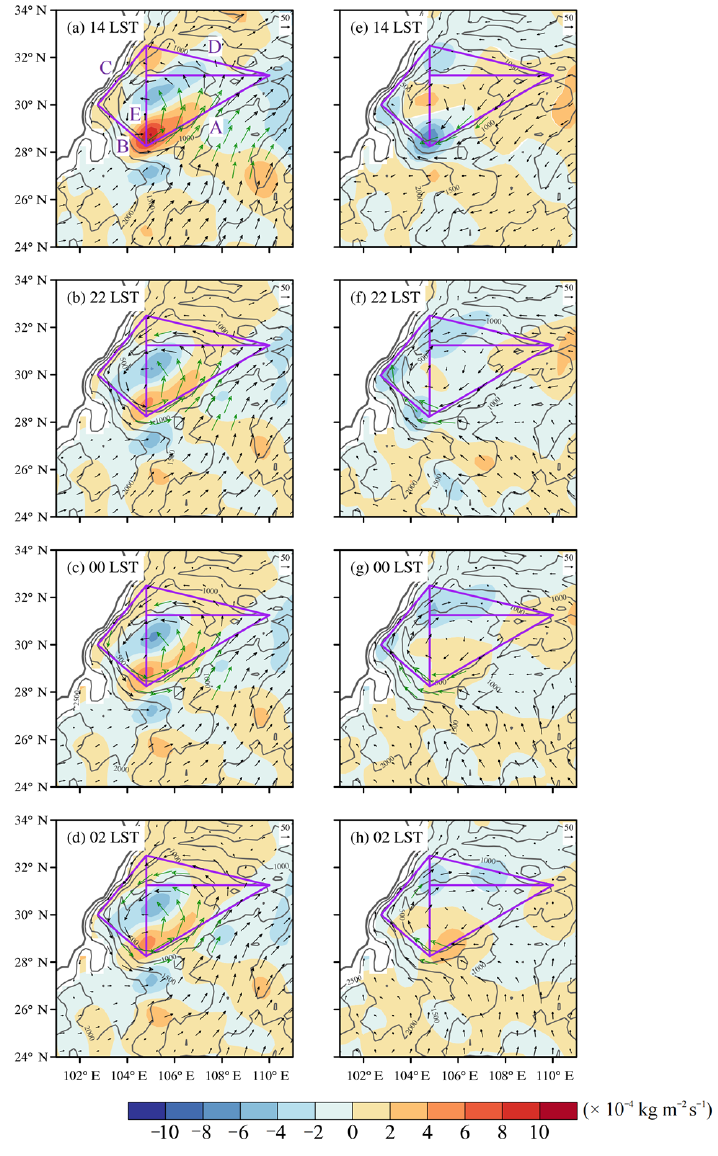
Figure 15. Diurnal variations of the moisture flux and the moisture flux divergence from surface— 700 hPa caused by ( a – d ) geostrophic circumfluence flows and ( e – h ) ageostrophic circumfluence flows. Purple lines in ( a ) represent boundaries A, B, C, D, and E.